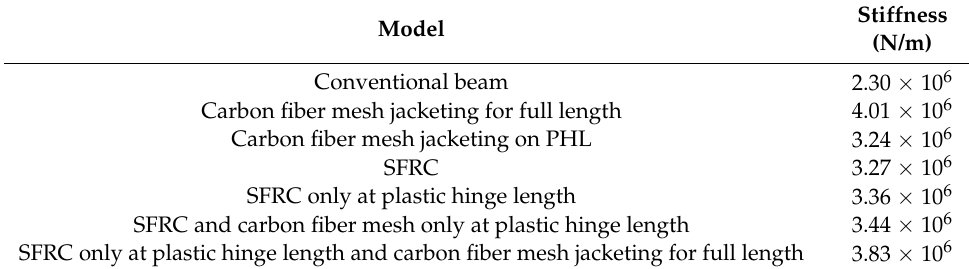
Table 12. Stiffness of different RC beams.